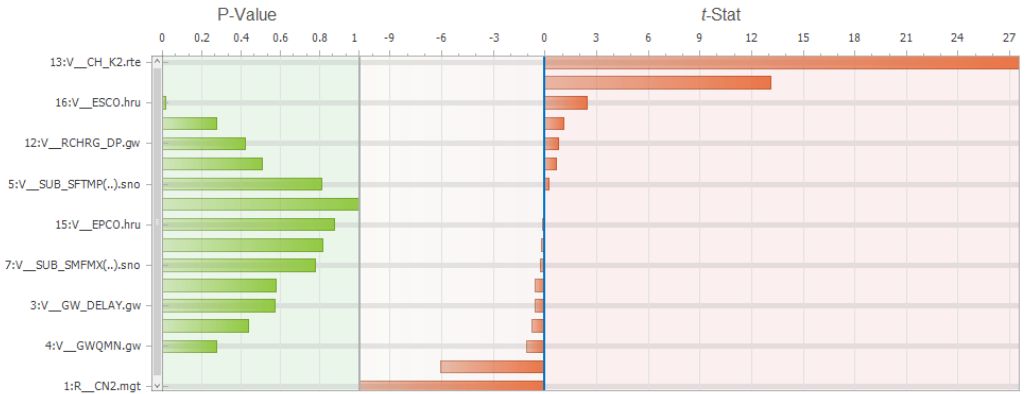
Figure 7. Model sensitive parameters of the study catchment. Table 3. Parameter sensitivity analysis.